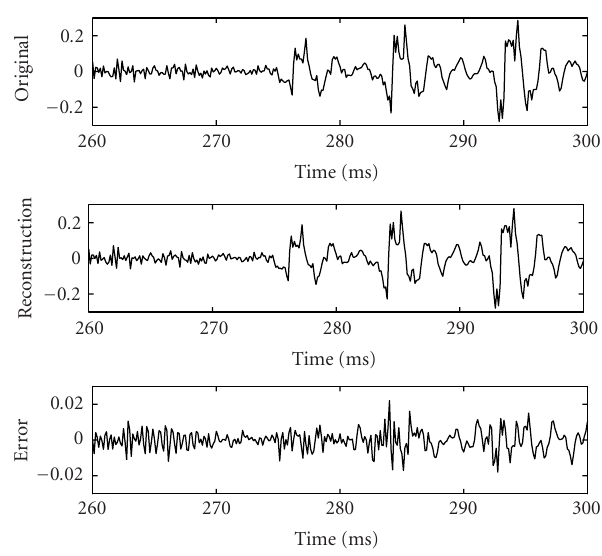
Figure 7: Comparison of the original waveform (upper plot), the waveform reconstructed from the auditory representation (middle plot), and the reconstruction error (lower plot, note the finer am- plitude scale). Speech segment taken from “The so urce,” spoken by a male